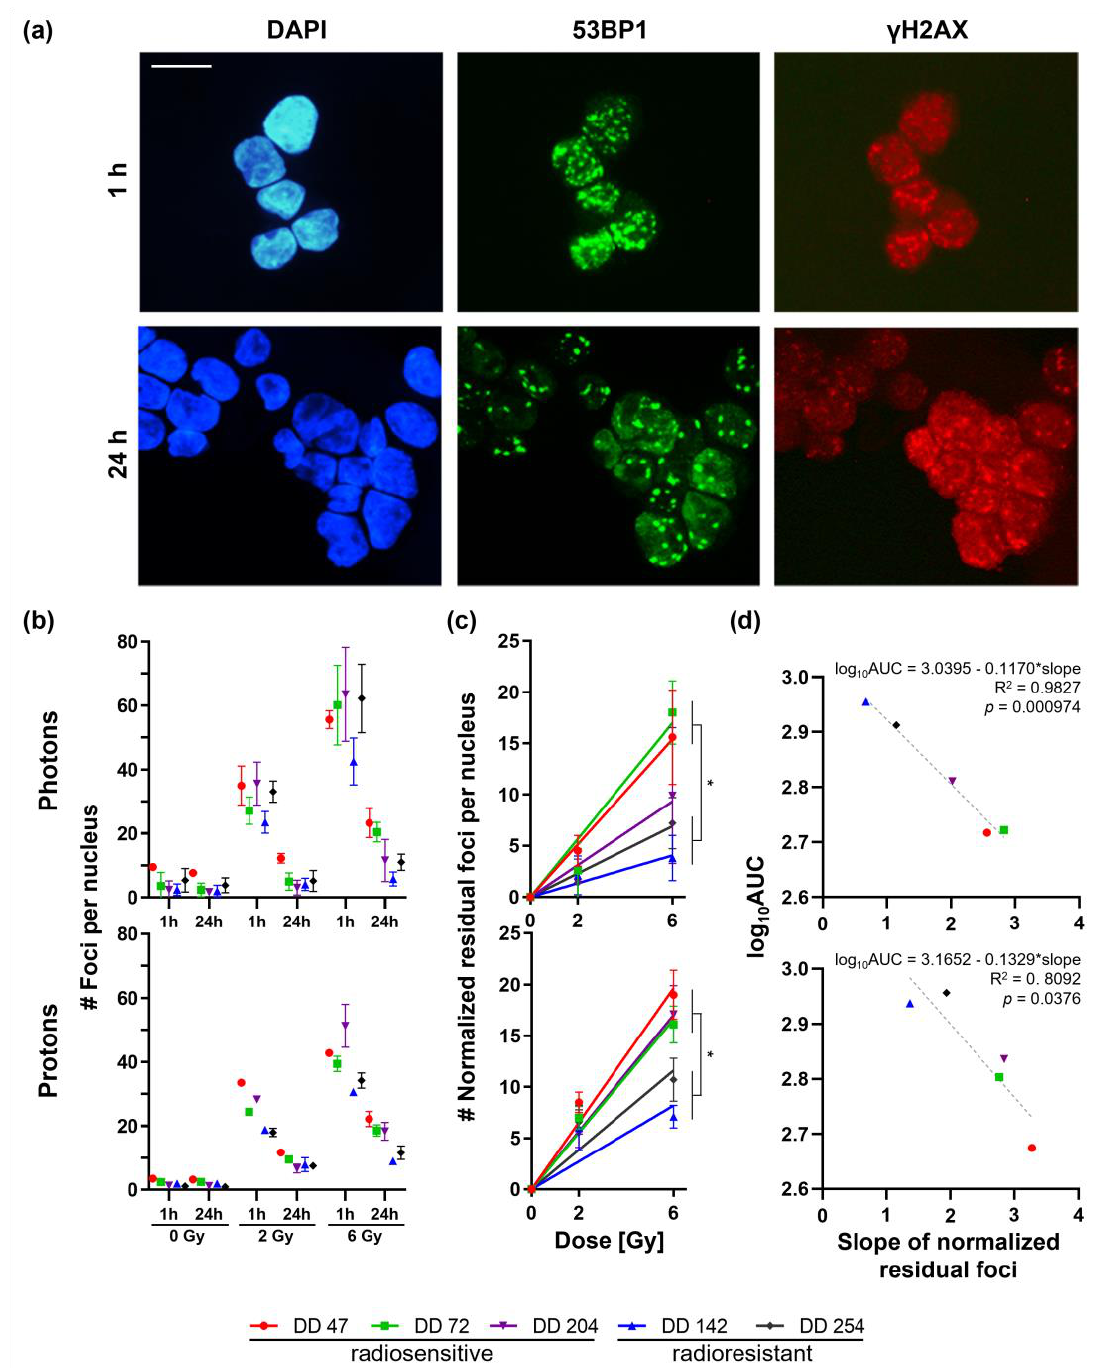
Figure 3. γ H2Ax/53BP1 foci assays of irradiated CRC PDOs. ( a ) Representative immunofluorescence stainings of DD142 for γ H2Ax/ 53BP1 1 h and 24 h after 6 Gy proton irradiation (scale bar: 10 µ M). ( b ) Foci per nucleus 1 h and 24 h post-treatment were counted for control (0 Gy), 2 Gy, and 6 Gy. ( c ) Slopes for normalized residual foci were determined ( t -test slopes of radiosensitive vs. -resistant PDOs: p photon ≤ 0.0396 (except DD204), p proton ≤ 0.0431). ( d ) Linear regression of viability (log 10 AUC, see Figure 2c) toward the slope of normalized residual foci revealed significant correlation (photons: R 2 = 0.9827, p < 0.001; protons: R 2 = 0.8092, p = 0.0376). *: p ≤ 0.05 .